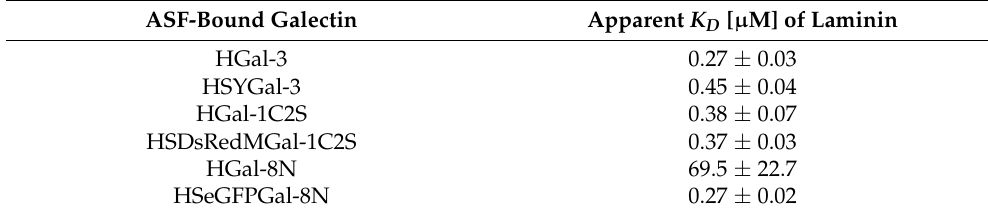
Table 5. Apparent K D values of laminin binding to ASF-bound His 6 -tagged and galectin fusion proteins of Gal-3, Gal-1C2S, and Gal-8N in a solid-phase binding assay. Values were calculated by non-linear regression assuming one-site